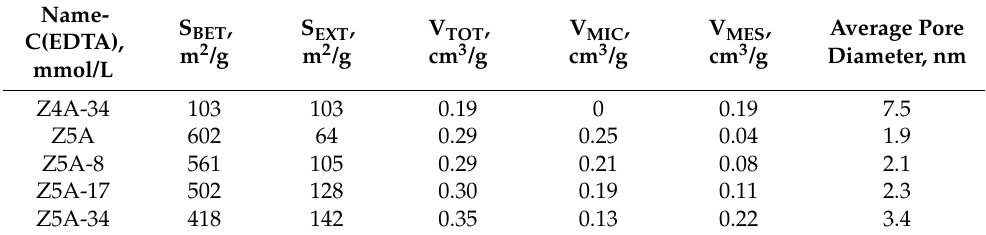
Table 2. The textural properties of the parent and EDTA dealuminated zeolite 4A and